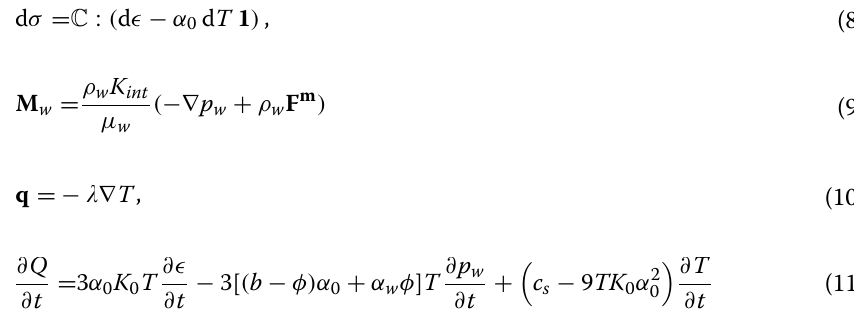
0 ficient, ρ w the initial fluid density [kg m namic flows σ , M w , and q are linearly linked to forces ǫ , ∇ p w , ∇ T according